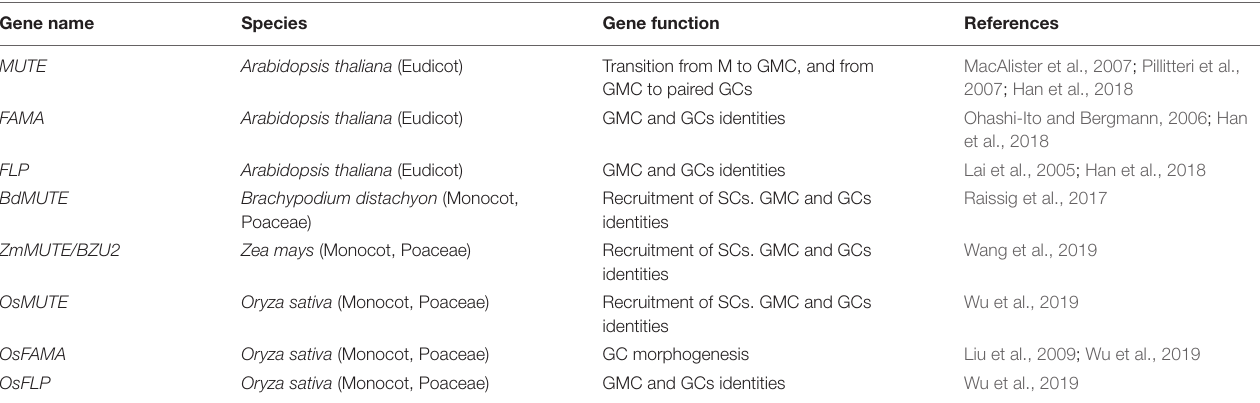
TABLE 1 | Role of MUTE, FAMA, and FLP , and their orthologs in